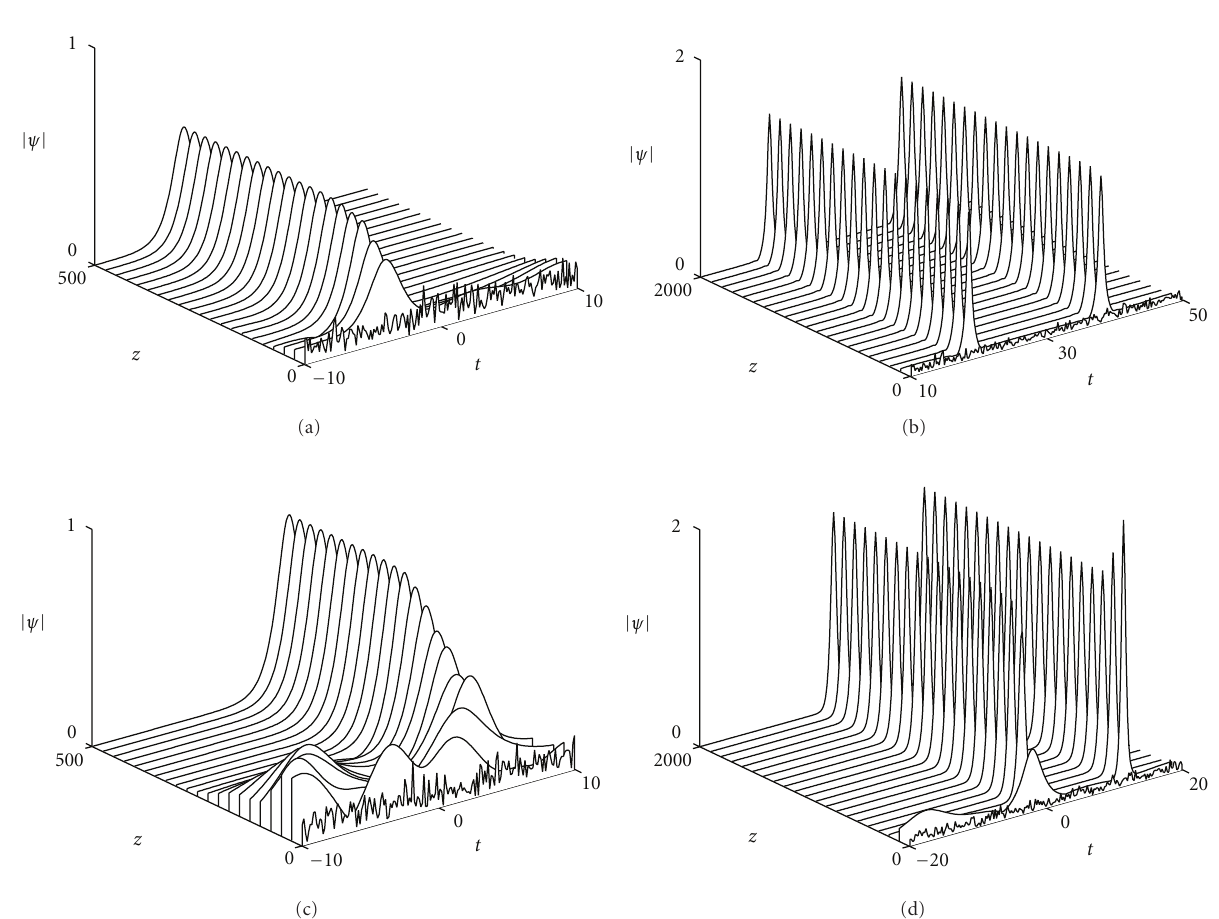
Figure 7: Numerical simulations of the full discrete governing system ((a) and (b), recall that | ψ | 2 = | u | 2 + | v | 2 ) and the SGLE ((c) and (d)) at di ff erent gain values g 0 in the anomalous dispersion regime. (a) and (c) Stable single-pulse evolution starting from white noise at g 0 = 1. (b) and (d) The initial white noise quickly evolves into two identical pulses per cavity round trip at g 0 = 2 . 7. The rest of the parameters in the simulations are D = 0 . 4, α 1 = 0, α 2 = 0 . 82 π , α 3 = 0 . 1 π , α p = 0 . 45 π , K = 0 . 1, Γ = 0 . 1, e 0 = 1, and τ = 0 . 1(from [29], 2011,